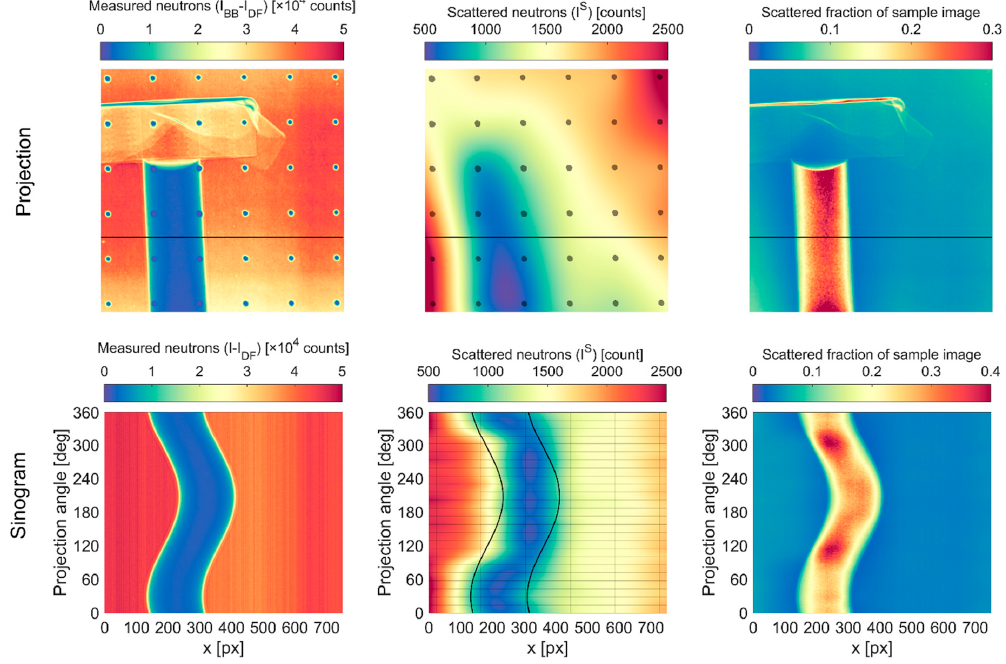
Figure 18. Scattering interpolation artifacts in CG-1D water column images. Images are pseudo- colored to enhance visual contrast. Horizontal line in projection images indicates slice used for sinogram images. Vertical lines in scattered neutron sinogram indicate BB locations, while horizontal lines indicate projection angles where BBs were used.